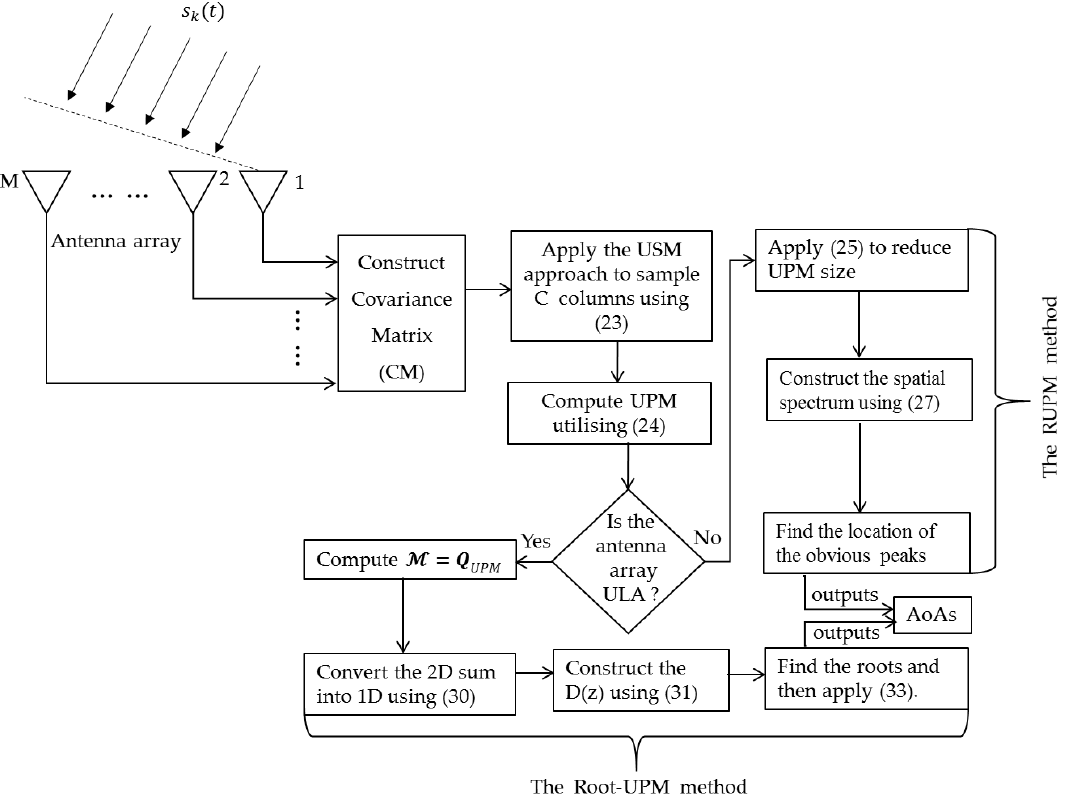
Figure 4. Showing the block diagram and the signal processing stages of the proposed AoA